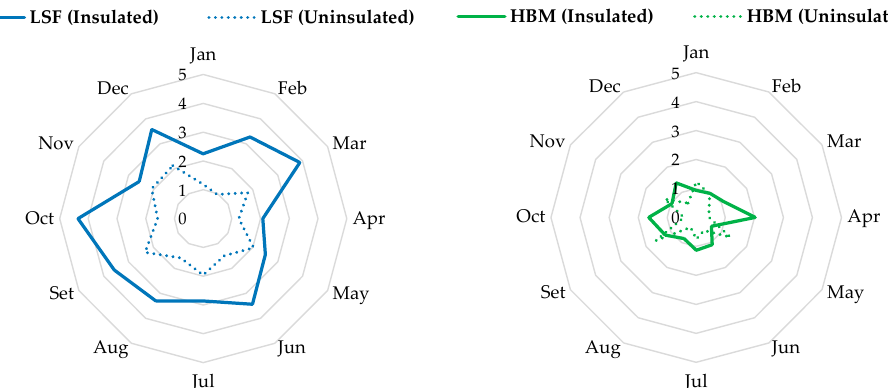
Figure 8. Monthly median indoor air temperature for the insulated and uninsulated experimental setups (°C).